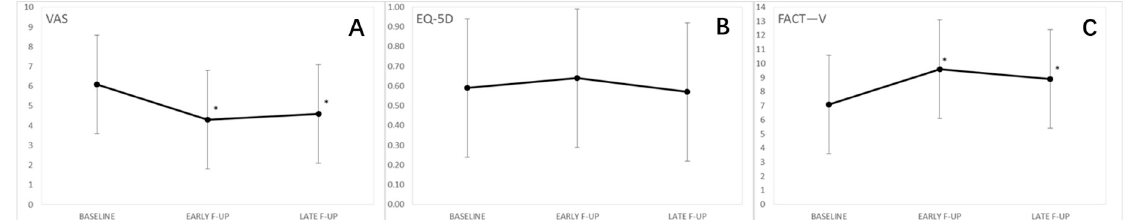
Figure 1. Quality of life in the whole study population. ( A ) Visual analog pain scale (VAS); ( B ) Functional Assessment of Cancer Therapy—Vulva cancer (FACT-V); ( C ) EuroQol 5-Dimension 5-Level (EQ-5D-5L). VAS and FACT-V improved significantly after ECT treatment while no changes were observed in EQ-5D-5L. *